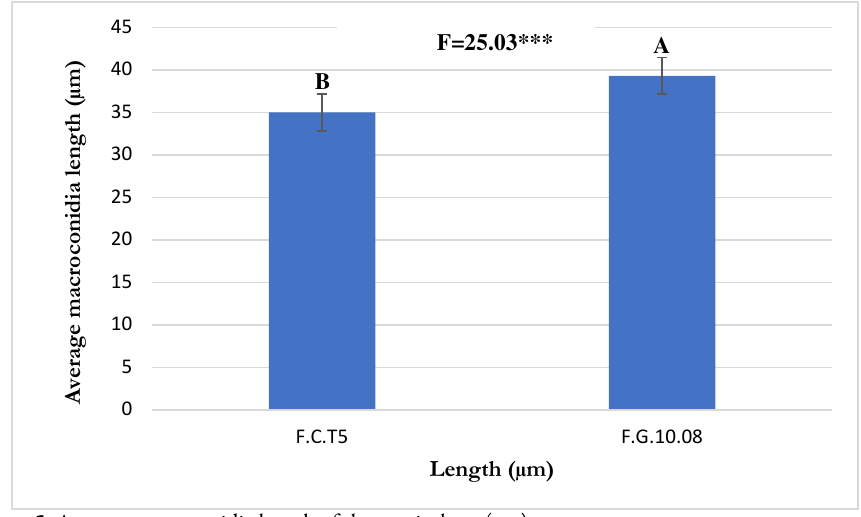
FigureFigureFigureFigure 5. 5. 5. 5. Average macroconidia length of the two isolates (µm)